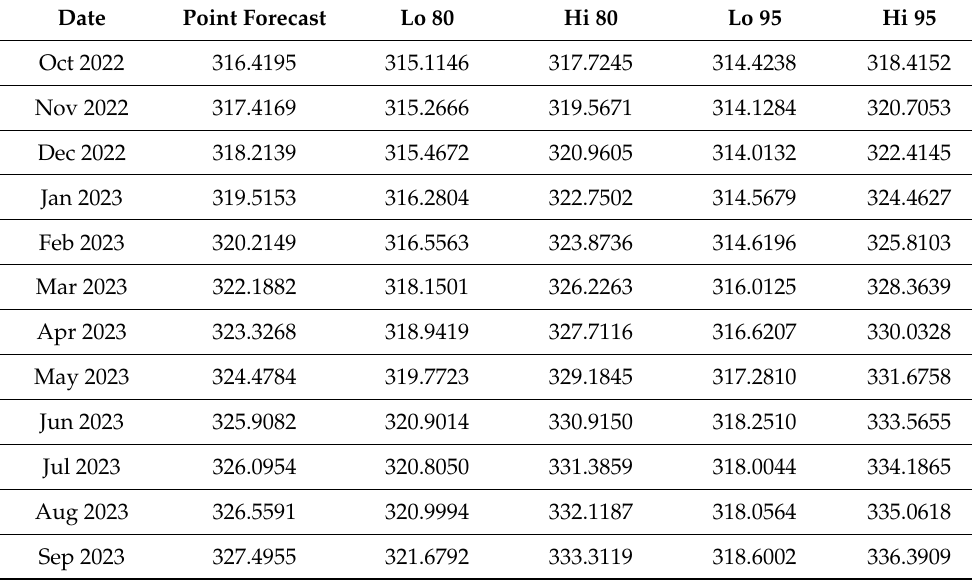
Table A4. Predicted CPI trend in Los Angeles. Own